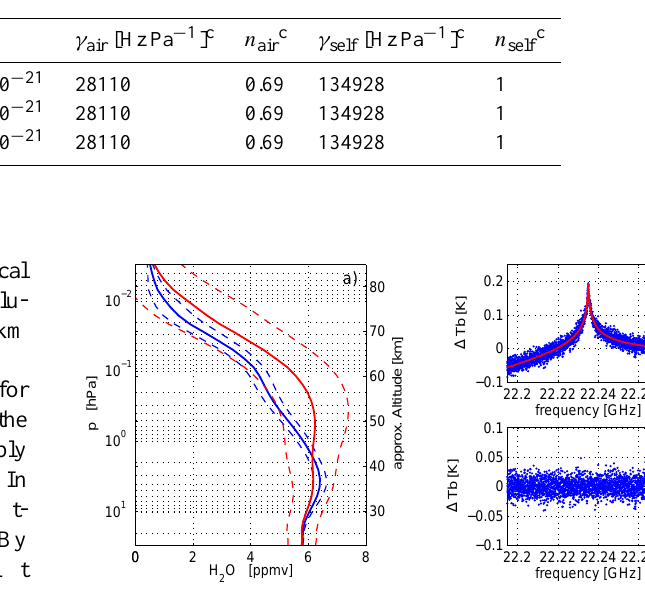
Table 1. Spectroscopic parameters of the 6 16 –5 23 transition of water vapour for T = 300K including hyperfine splitting ( ν 0 is resonant frequency; S , line intensity; E 00 , lower state energy; γ air , air broadening parameter; n air , temperature dependence of γ air ; γ self , self broadening parameter; and n self , temperature dependence of γ self ). The source of the single-line parameter is given in the header, the splitting of the intensity into three lines follows Seele (1999).